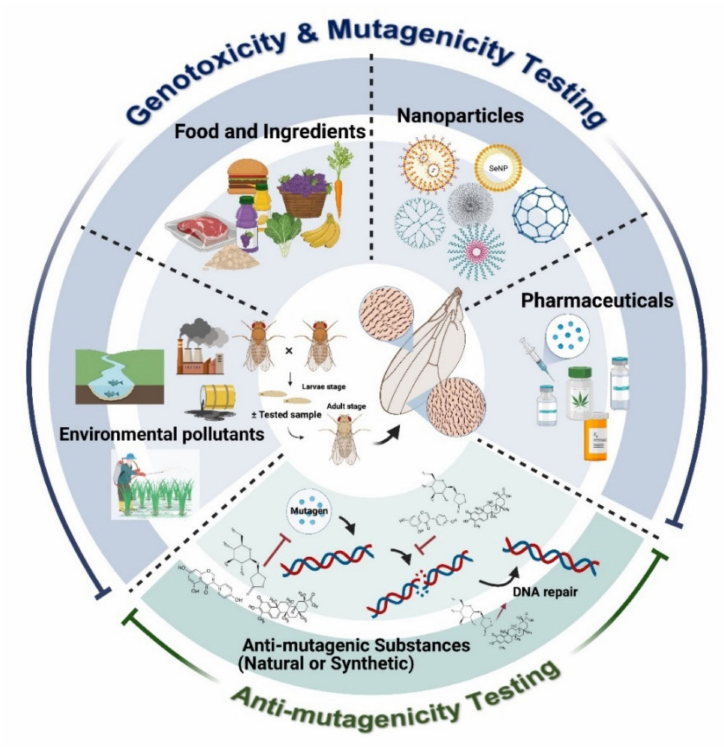
Figure 1. Applications of SMART or wing spot test in human hazard assessment covering food and drug safety, nanoparticles, pesticide and herbicide, and environmental safety. SMART is also applied to test anti-mutagenicity properties of the interested